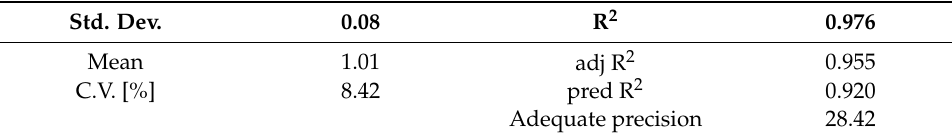
Table 5. Statistics of fitting for a second-order polynomial model. Std.